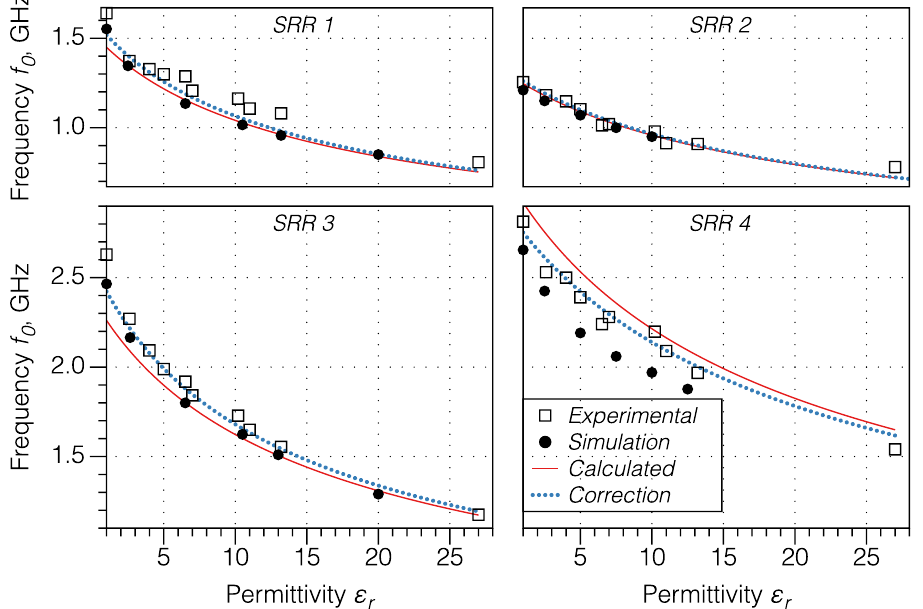
Figure 2. The analytical (red solid curve), measured (open squares) and simulated (filled circles) resonant frequency f 0 of the SRR probe as a function of the dielectric permittivity ε r of materials for the different SRR geometrical parameters given in Table 2. Corrected curves (blue dotted line) for the analytical approach were obtained by using alternative fringing gap capacitance. The range of dielectric permittivities was provided by using ABS-based polymeric composites with different fractions of micron-scale inorganic powders such as BaTiO 3 , and were previously characterized using a standard split post resonator technique.